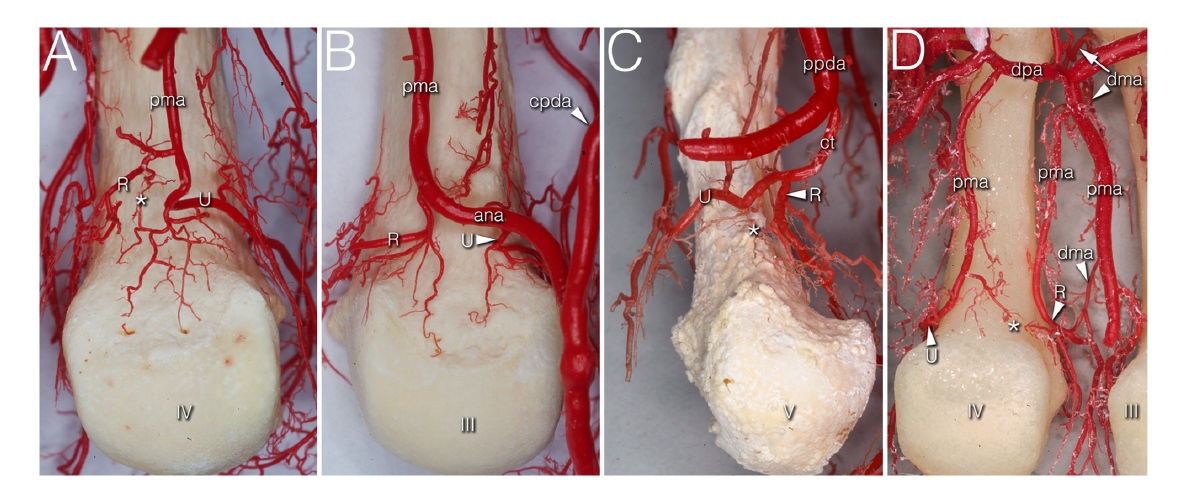
FIGURE1 Variations of R- and U- branches on corrosion cast specimens (palmar view). (A) Dominant U-branch as a continuation of the palmar metacarpal artery. Note the two palmar enosseal vessels originating as a common trunk from the U-branch. (B) The U-branch originates from the anastomosis between the palmar metacarpal artery and the common palmar digital artery. (C) The R- and U-branches originate as a common trunk from the 10th proper palmar digital artery. (D) The R-branch originates from the early dividing neighboring palmar metacarpal artery. The U-branch is the continuation of a separately originating palmar metacarpal artery. Note the dorsal metacarpal artery anastomosing with the R-branch. ana, anastomosis between the palmar metacarpal artery and the common palmar digital artery; *, anastomosis between R and U branch; cpda, common palmar digital artery; ct, common trunk; dma, dorsal metacarpal artery; dpa, deep palmar arch; pma, palmar metacarpal artery; ppda, proper palmar digital artery; R, R-branch; U, U-branch; III, IV, V: 3rd, 4th, and 5th metacarpal heads.